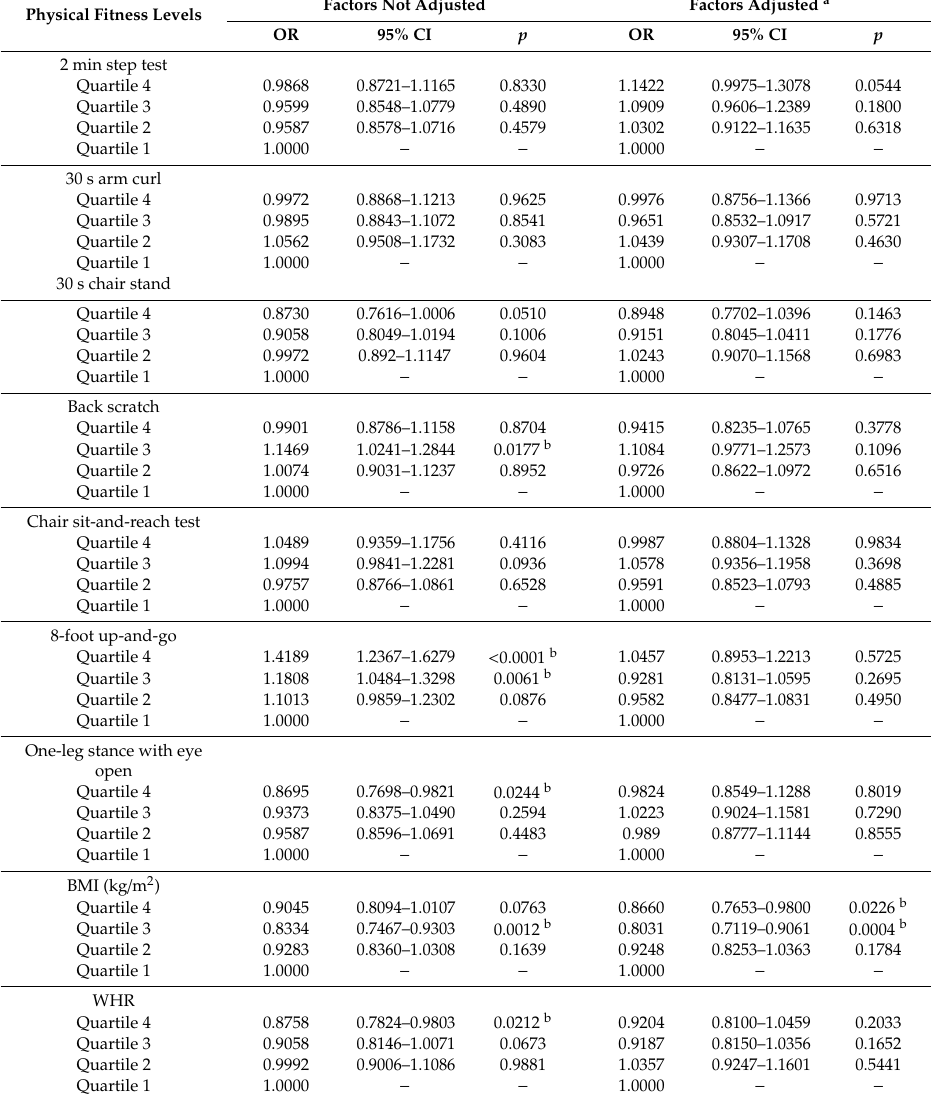
Table 3. Multivariate adjusted ORs for short sleep duration ( ≤ 5 h / day) in relation to each physical fitness measurement after adjustment for potential